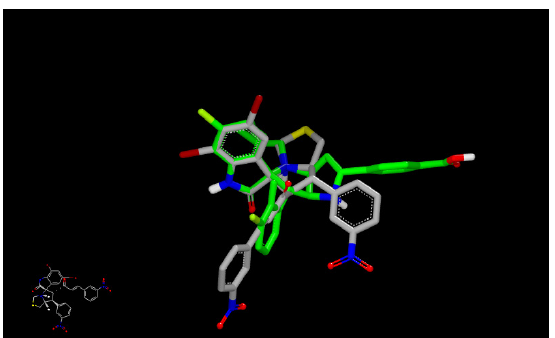
Figure 2. Shape similarity of 5g with BI-0252 as analyzed by Rapid Overlay Shape Chemical Structure (ROCS) and visualized by VIDA application.